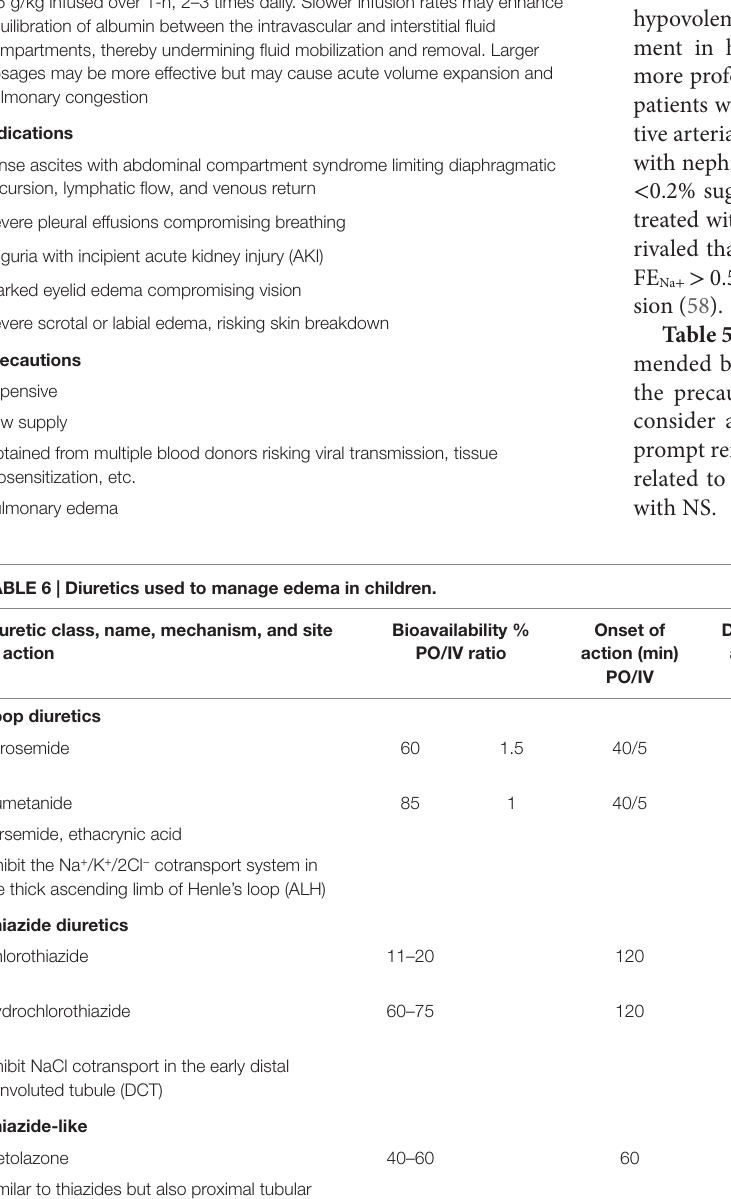
TABLe 5 | Albumin infusion in the management of edema in NS. Dosing of salt-poor albumin (25% SPA, or, 25 g/100 mL) 0.5 g/kg infused over 1-h, 2–3 times daily. Slower infusion rates may enhance equilibration of albumin between the intravascular and interstitial